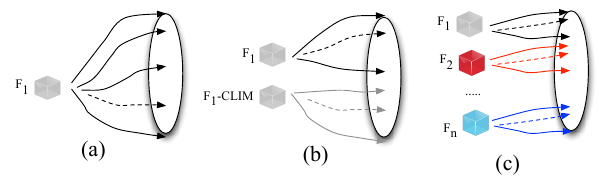
Figure 1. Schematic of the three strategies used to specify forcing uncertainty in the data assimilation integrations: (a) a single forcing dataset, (b) a single forcing dataset and its climatology and (c) an ensemble of forcing products. In all three cases, perturbations are applied to the forcing inputs to generate the